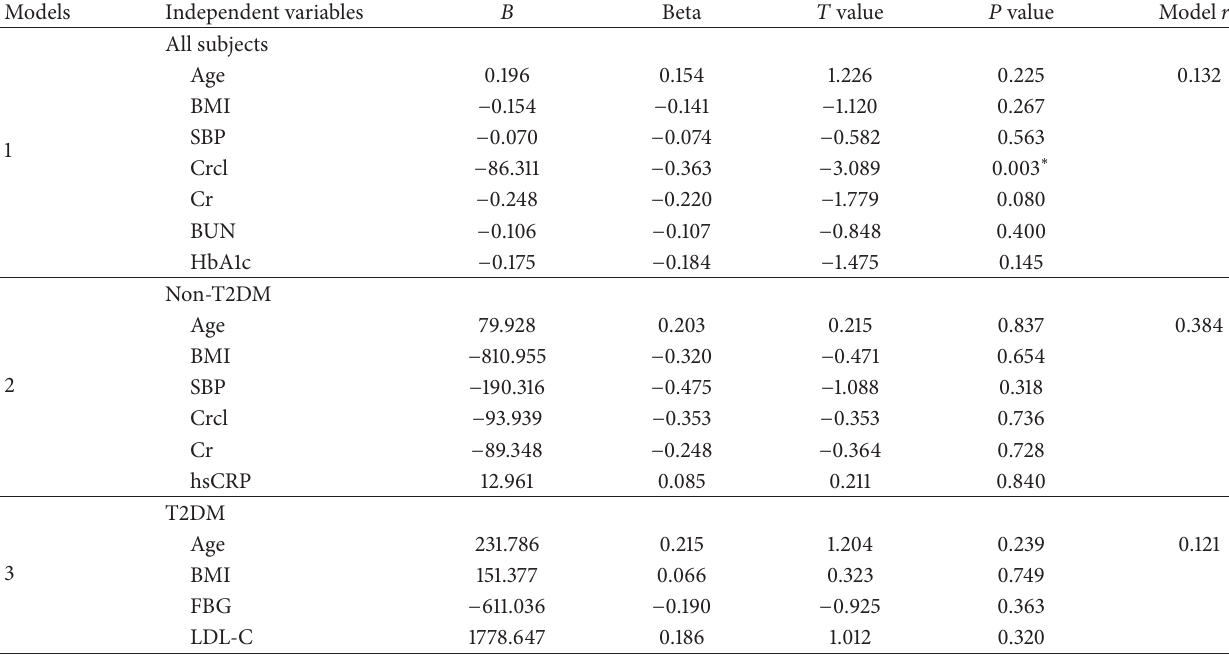
Table 6: Multivariate linear regression analyses of all subjects, patients with and without T2DM, using the serum adiponectin levels as dependent variables.